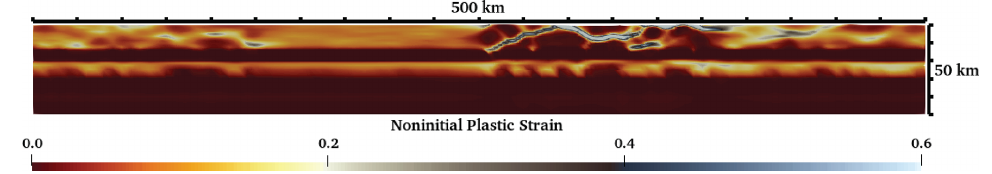
Figure B8. Cross section traversing all domains at x = 250km, perpendicular to those shown in Figs. B2–B7. Cross section shows the non-initial plastic strain. See Fig. 4a for a 10Myr snapshot. Screenshot taken at 10Myr.